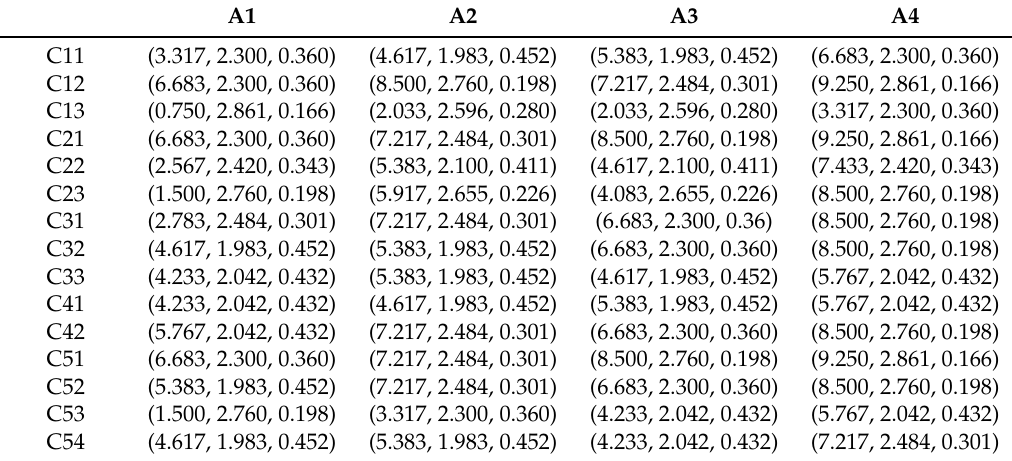
Table 7. The aggregation cloud for the sub-criteria of four site alternatives.